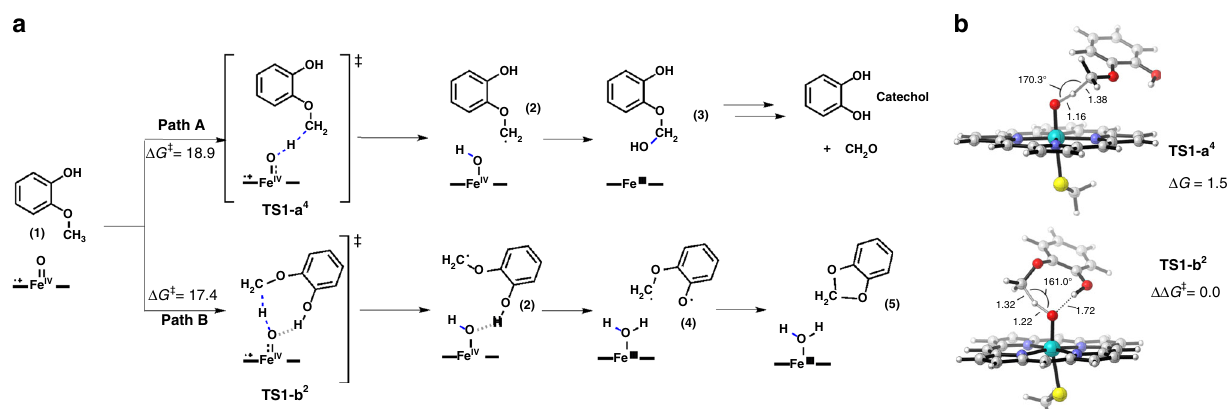
Fig. 6 Proposed GcoA-catalyzed reaction mechanisms for the degradation of guaiacol. a Schematic representation of the two potential reaction paths catalyzed by GcoA P450. Path A generates the hemiacetal (3), which will hydrolyze into the observed catechol and formaldehyde. Path B could generate a stable and unproductive acetal (5). b Path A and B DFT optimized H-abstraction rate-limiting transition states. Gibbs energies are given in kcal mol − 1 , distances in Å, and angles allowing water to enter the enzyme. Overall, the presence of guaiacol or catechol in the binding site keeps the three Phe residues arranged around the ligand and prevents the full closed- to-open transition of the active site.